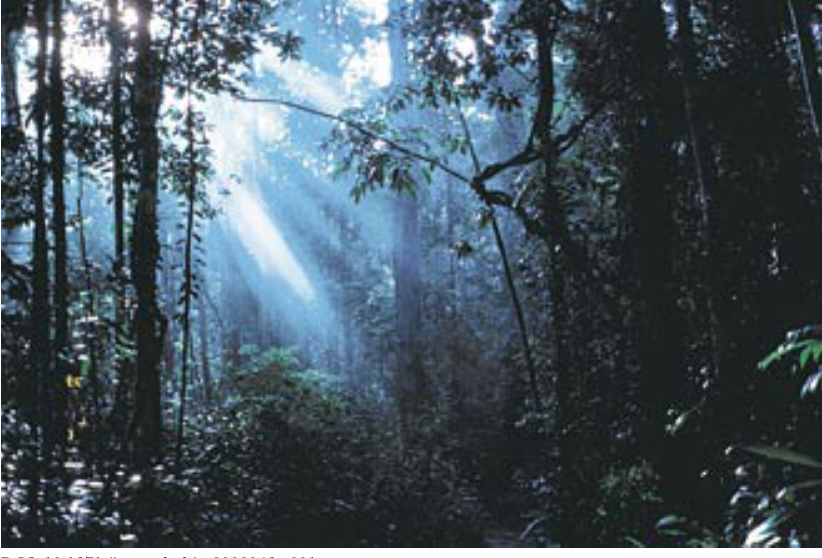
Figure 1. Paraguay Atlantic Forest The lush forested ecosystems of the Atlantic Forest, such as shown here in Paraguay, have been cut to less than 7% of their original extent, eliminating the habitat for thousands of plant and animal species. (Photograph by Russell